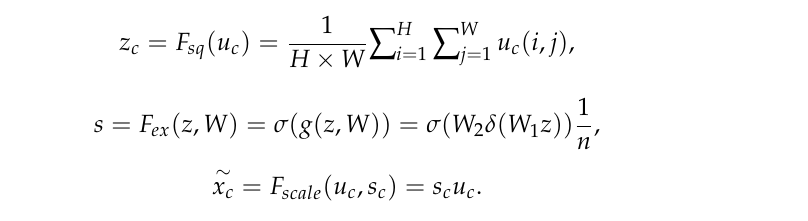
Table 2. MobileNetV2+ SENet network structure.